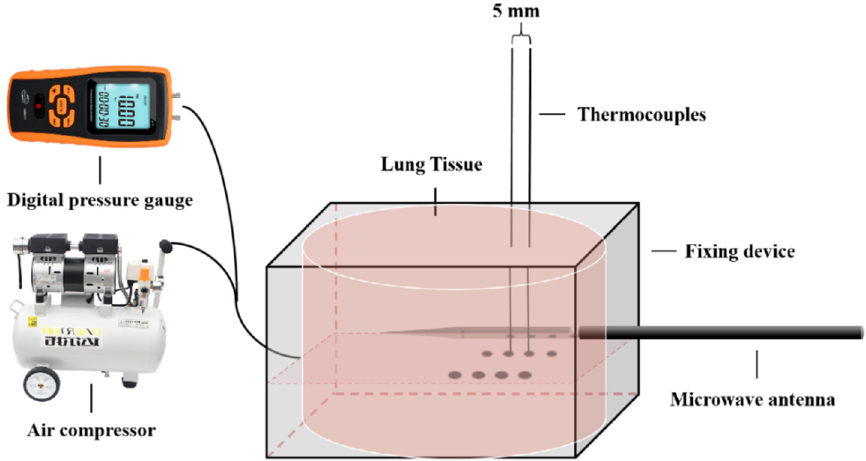
Figure 2. Distribution map of microwave antennas and temperature measurement points 3D dia- gram.